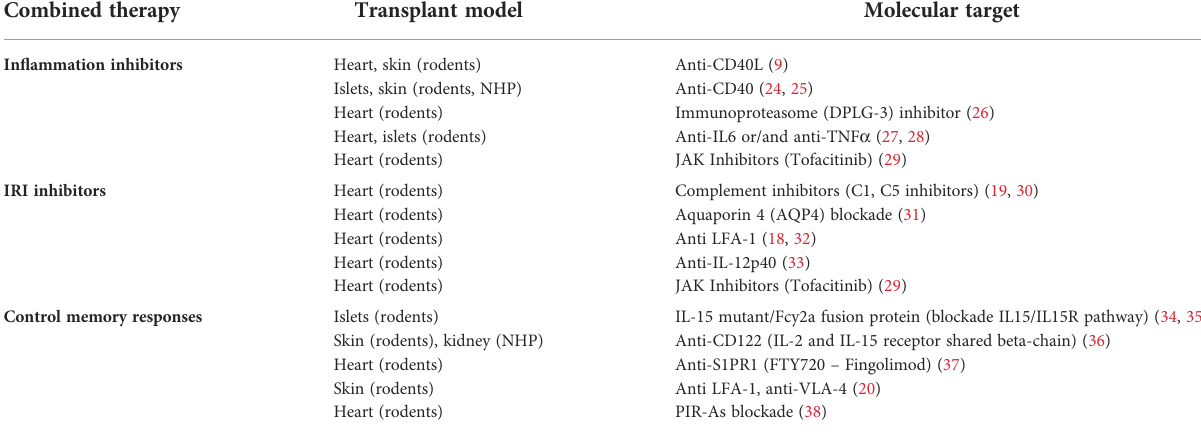
TABLE 1 List of tested experimental strategies to improve CTLA4-Ig ef fi cacy in extending transplant survival. Combined